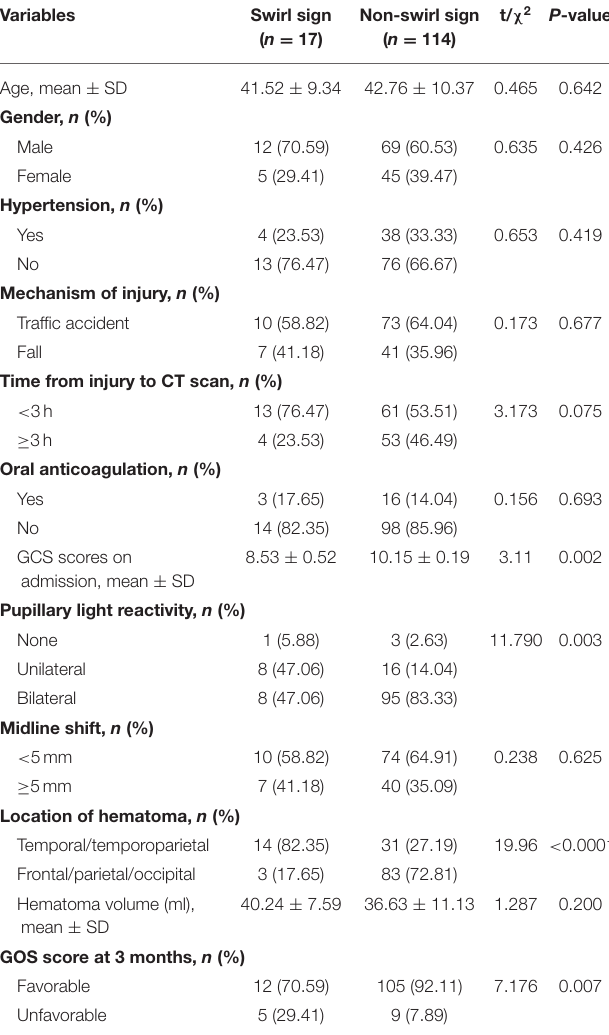
TABLE 1 | Clinical and radiological characteristics of patients with swirl sign and without swirl sign [ n (%)].